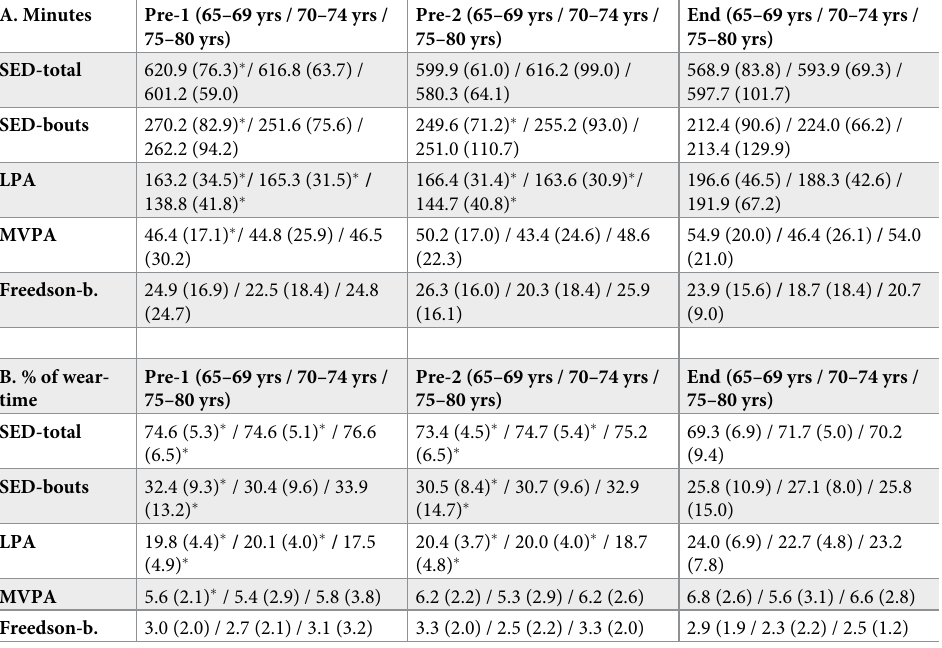
Table 5. Age group (65–69 yrs, 70–74 yrs and 75–80 yrs) average values ( ± SD) in min/day (A-above) and in %-of- wear-time (B-below) for various accelerometer parameters in the exercise group. Significant difference (p < 0.0025) between End-test and either of the two pre-tests, within each age group is marked at each pre-test with � . A.